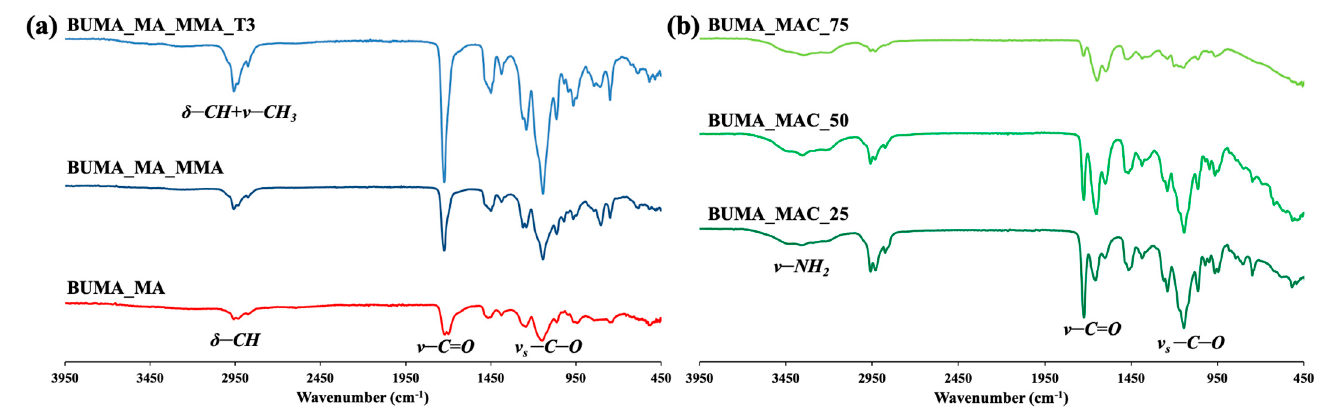
Figure 1. Fourier transform infrared (FT-IR) spectra of ( a ) BUMA_MA and BUMA-based terpolymers and ( b ) BUMA_MAC copolymers.